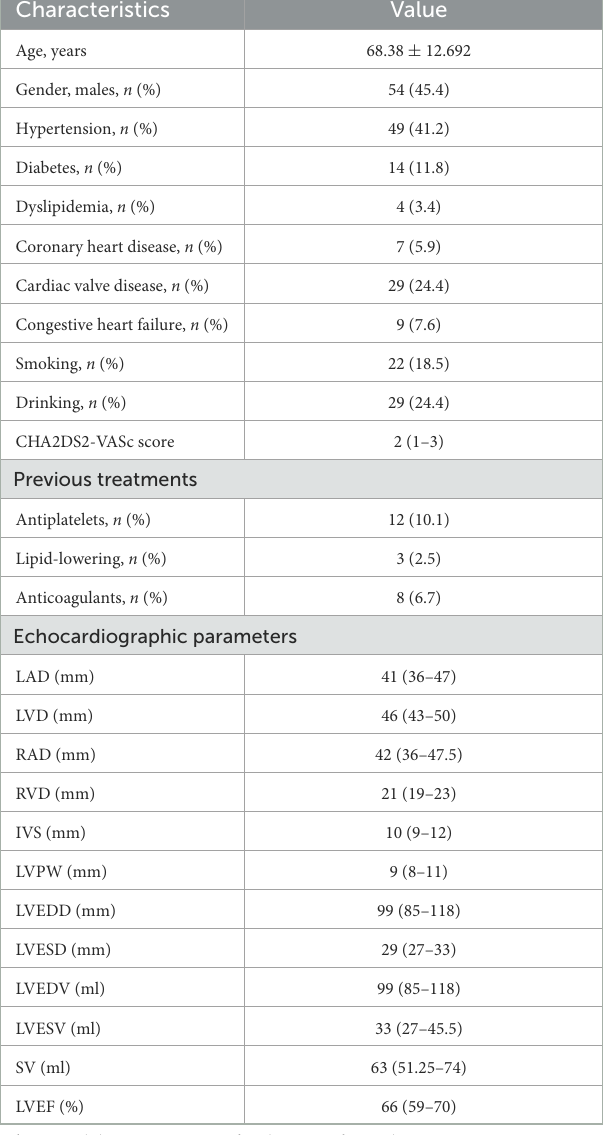
TABLE 1 Baseline characteristics and echocardiographic parameters of the study